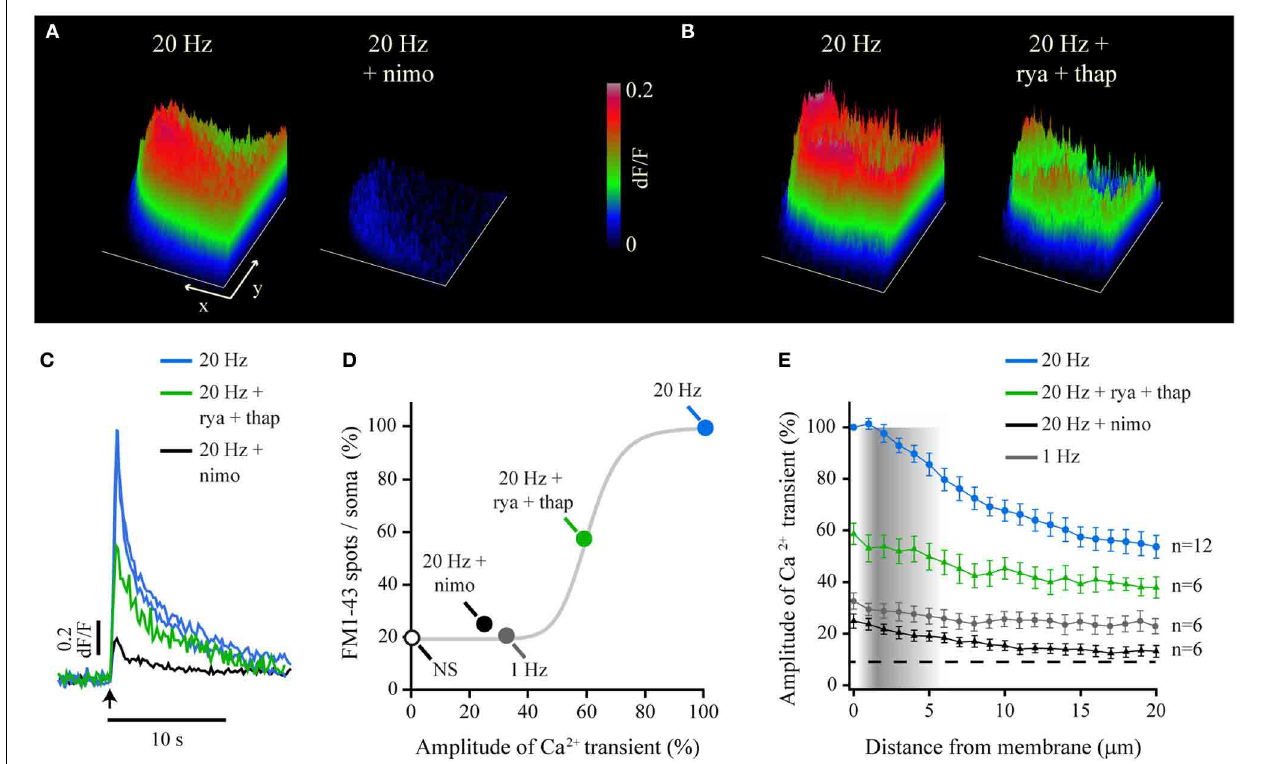
FIGURE 3 | Transmembrane and intracellular Ca 2 + produce the fast Ca 2 + transient and exocytosis. (A) Surface plots of the peak Fluo-4 fluorescence upon 20-Hz stimulation before (left) and after (right) blockade of L-type Ca 2 + channels with nimodipine (nimo). The x and y scale bars = 10 µ m. The z-axis indicates the relative (dF/F) fluorescence levels as calibrated on the right bar (also applies for B). (B) Surface plots before (left) and after (right) blockade of Ca 2 + -induced Ca 2 + release with a combination of ryanodine (rya) and thapsigargin (thap). (C) Superposition of the kinetics of representative Ca 2 + transients recorded from the submembrane shell under the experimental conditions shown above. The blue traces are responses to control 20-Hz trains in the same neurons before addition of nimodipine (black trace) or the combination of